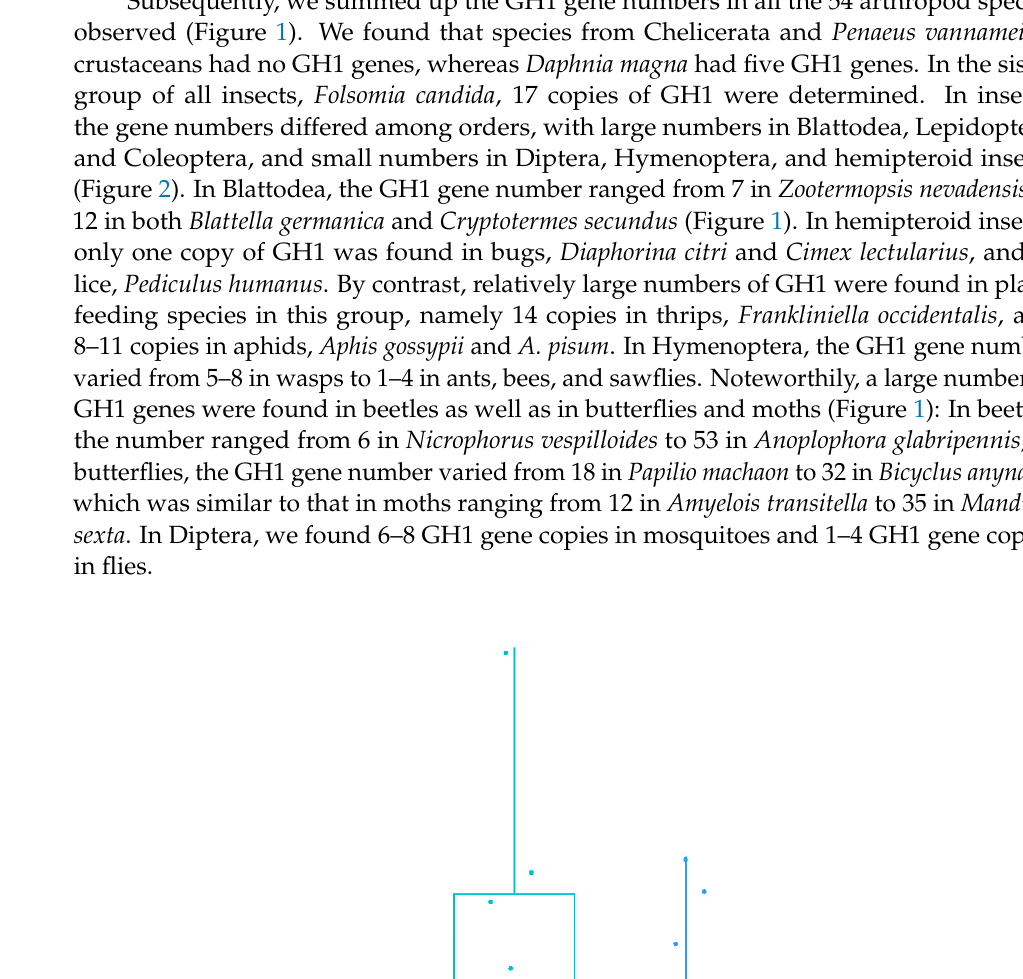
Figure 3. The GH1 gene numbers in different insect groups; * indicates significant differences be- tween groups. ( a ) the comparison of GH1 gene number between non-herbivores and herbivores; ( b ) the comparison of GH1 gene numbers among non-herbivores and separated herbivory groups, in- cluding direct plant-cell-wall and non-direct plant-cell-wall. 3.3. Phylogenetic Tree of GH1 Genes in Insects The phylogeny of GH1 was built with protein sequences of identified genes from selected species. According to the phylogeny, the insect GH1 family could be separated